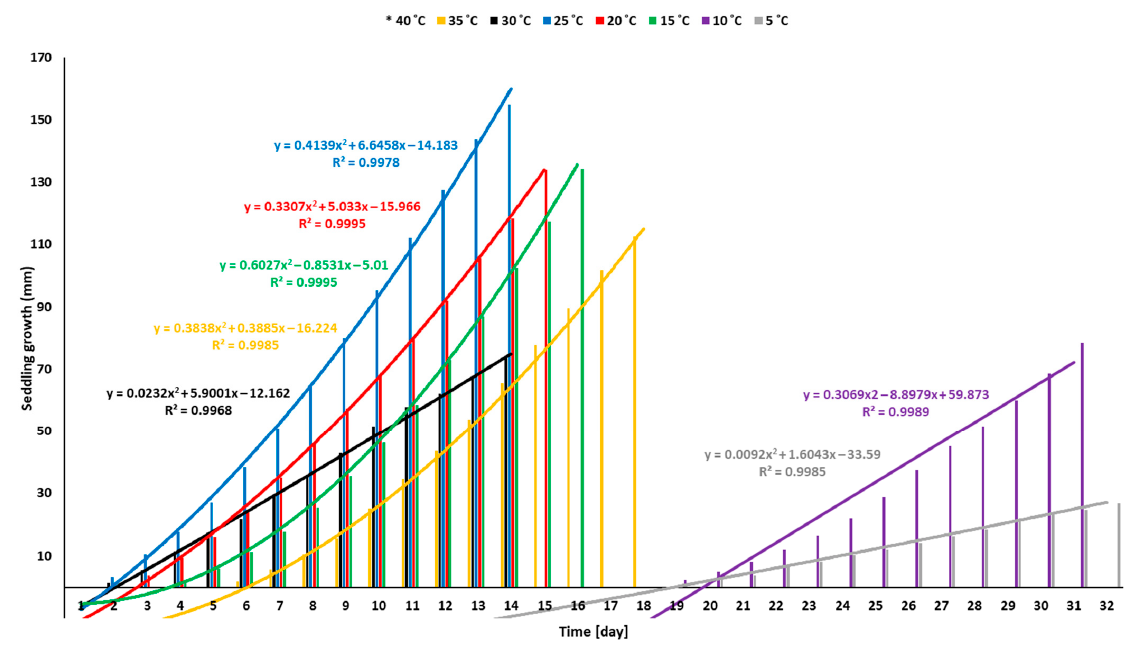
Figure 2. Germination and seedling growth of sunflower seeds vs. time at different levels of temperature. The * represents 40 °C which is not shown on the graph because its value is zero (no temperature. The * represents 40 ◦ C which is not shown on the graph because its value is zero germination). (no